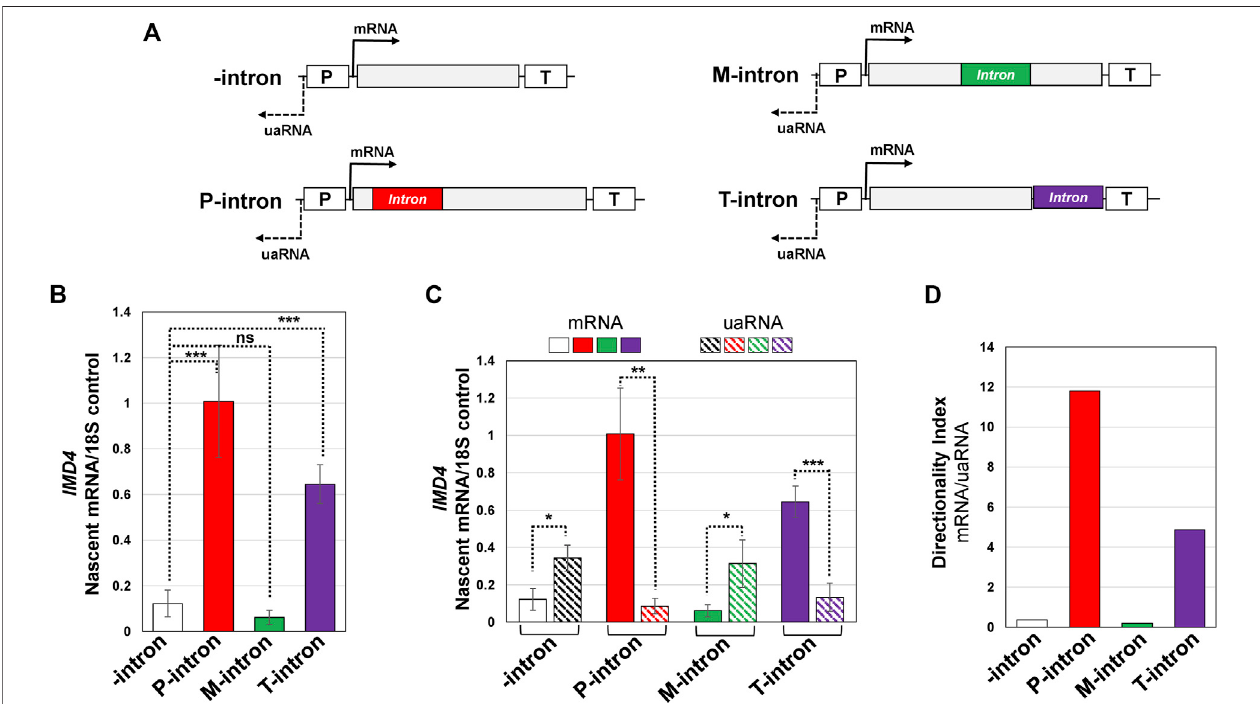
FIGURE 4 | Both the promoter and terminator proximal introns enhance transcription and promoter directionality of IMD4 gene. (A) Schematic depiction of IMD4 gene without intron (-intron, white), and with ACT1 intron inserted near the promoter (P-intron, red), in the middle ofthe gene (M-intron, green)and in theproximity ofthe terminator (T-intron, purple) region. “ p ” and “ T ” stand for the promoter and terminator respectively. (B) TRO analysis of IMD4 in the absence of an intron (white bar), and with the intron inserted near the promoter (red bar), in the middle (green bar) and toward the terminator region of the gene (purple bar). (C) Measurement of mRNA and uaRNA levels of IMD4 in the 400 bp upstream (uaRNA) and downstream (mRNA) promoter proximal region by strand-speci fi c TRO approach in the absence of an intron(whitebarformRNA,diagonalblackpatternbarforuaRNA),andwiththeintroninsertednearthepromoter(redbarformRNA,diagonalredpatternbarforuaRNA), inthemiddle(greenbarformRNA,diagonalgreenpatternbarforuaRNA)andtowardtheterminatorregionofthegene(purplebarformRNA,diagonalpurplepatternbar for uaRNA). (D) Directionality index of IMD4 without intron (white bar) and with the intron present at three different positions (red, green and purple bars) by comparing levels of mRNA vs. uaRNA produced. The 18S signal was used as a normalization control in these experiments. Results presented here represent three biological replicates and six technical replicates. The values and error bars for each condition indicate the mean ± standard deviation. Statistical signi fi cance ( p -values) was determined using the two-tailed paired Student ’ s t -test. One asterisk (*) signi fi es a p value equal to or smaller than 0.05 ( p ≤ 0.05). Any non-signi fi cant difference is represented by ns ( p >